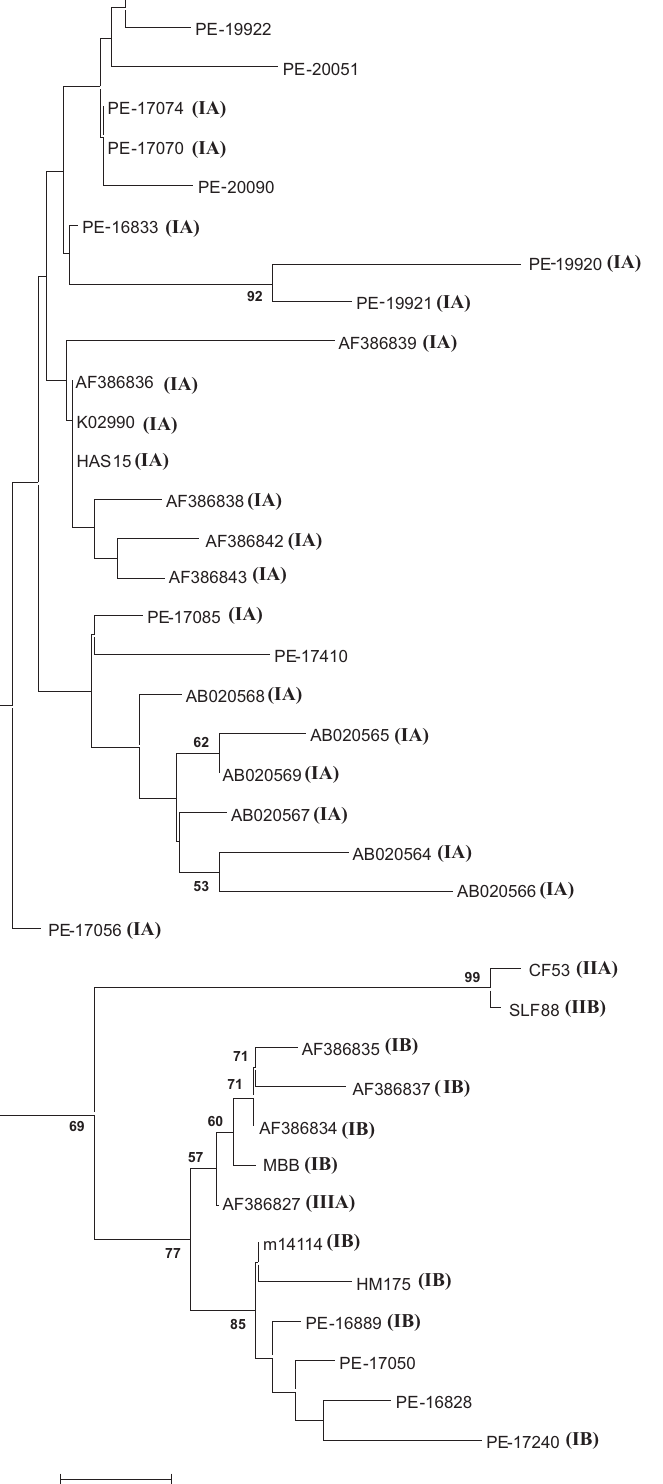
Figure 2. Phylogenetic tree analysis of the 5’NTR in hepatitis A virus (HAV) isolates from Pernambuco (PE). A 290-bp segment of the HAV 5’NTR was analyzed using the two-parameter model of Kimura (see Ref. 15). The numbers on the branches show bootstrap percentages obtained after 1000 replicates of boot- strapping sampling. The length of bars shows dis- tances. The numbers in parentheses indicate the geno- type of this isolate according to the VP1/2A region. Note that not all of the 5’NTR sequences were ampli- fied in the VP1/2A region. Isolate AF386827, displayed in the box, belongs to genotype IIIA and clusters with IB strains. Reference sequences from Genbank included genotype IA strains (HAS15 x15464), genotype IB strains (HM175 m14707) (MBB m20273), genotype IIB strain (SLF88 ay644670), genotype IIA strain (CF53 aj299464), and other sequences from acute cases of hepatitis A virus that appear as the Genbank